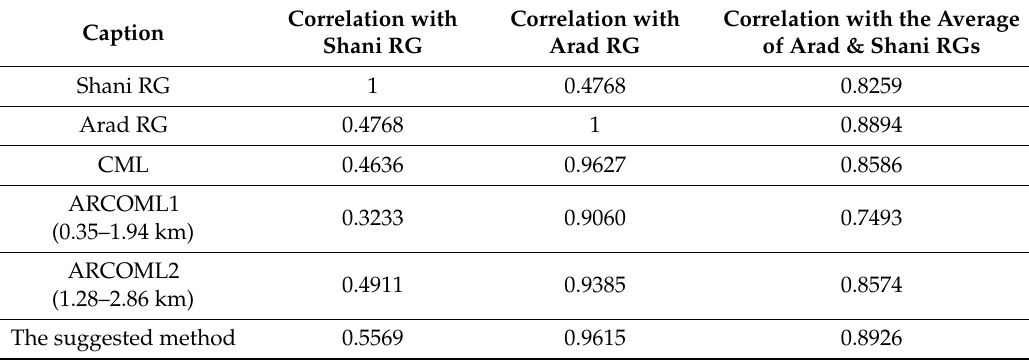
Figure 3. May 2014 event, top subplot: estimated rain rates at the Cl B (brown) and the average humidity (green circles). Bottom subplot: estimated Cl B levels (brown stars), the average of the estimated Cl B (brown), the average of a real Cl B measurements nearby (blue), and the average humidity (green circles). Table 1. The correlation of the ground truth rain rate measurements of Rain Gauges (RGs) in Arad, Shani and their average, with the different measurement sources for rain rate (RGs, Commercial Microwave Link (CML), Averaged Radar Cells Over Microwave Link (ARCOML) at two different elevations, and the suggested method of estimating rain rates near ground by combining radar and microwave link measurements) over the duration of 25 h on 7–8 May 2014 at the experiment site between the cities of Arad and Shani in southern Israel. Values marked in green show best values, values marked in yellow show second-best values for a specific